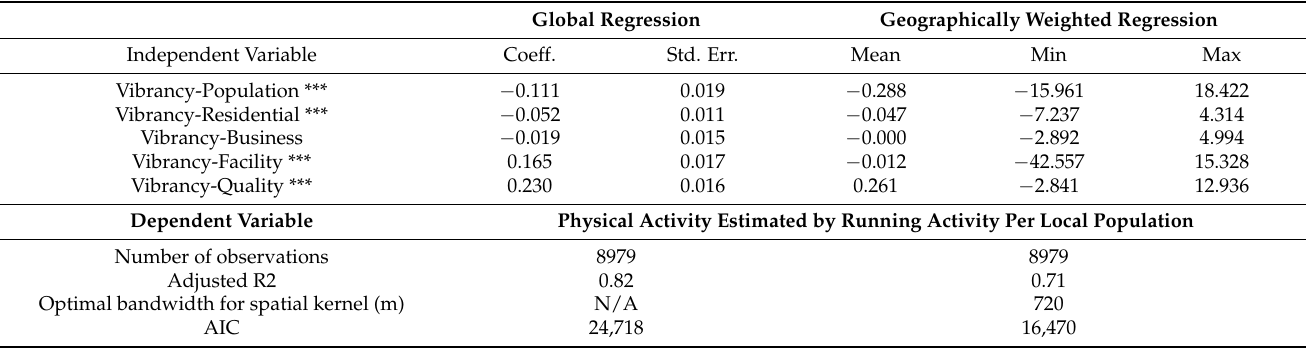
Table 3. Results from a global regression and GWR model.